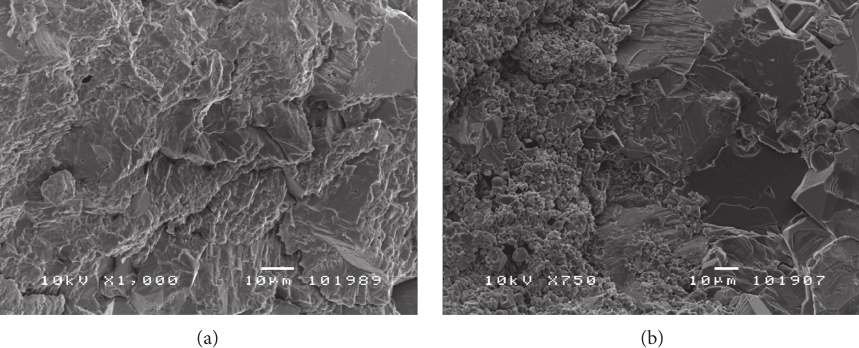
Figure 24: Local microscopic fracture morphology. (a) Slip separation morphology, − 30 ° C, × 1000. (b) Granular fracture morphology, − 40 ° C, ×